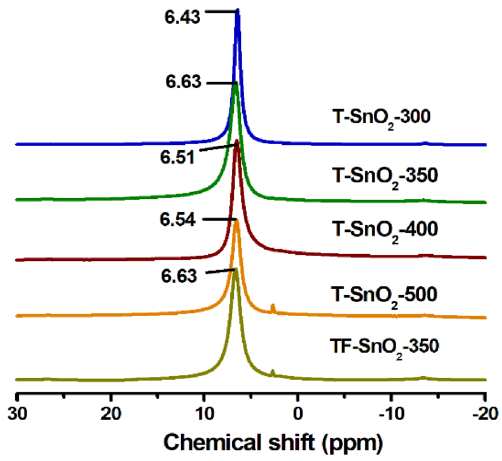
Figure 2. 1 H MAS NMR of SnO 2 catalysts. (Reproduced from reference 3